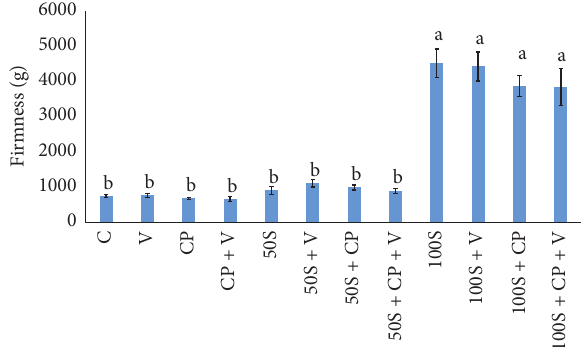
Figure 4: Firmness values for muffins containing two levels of stevianna as sugar replacer with or without cocoa powder and vanilla. Control (C); vanilla (V); cocoa powder (CP); cocoa + vanilla (CP + V); 50% stevianna (50S); 50% stevianna + vanilla (50S + V); 50% stevianna + cocoa (50S + CP); 50% stevianna + cocoa + vanilla (50S + CP + V); 100% stevianna (100S); 100% stevianna + vanilla (100S + V); 100% stevianna + cocoa (100S + CP); 100% stevianna +